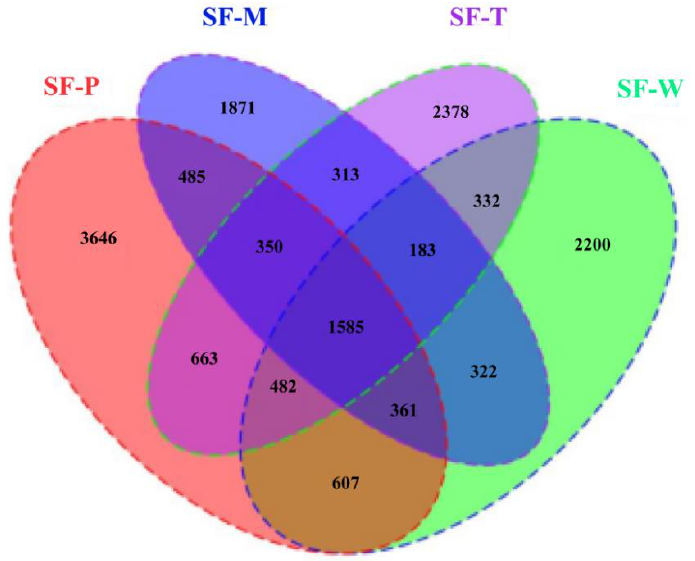
Figure 3. Venn diagram of taxonomical operational units (OTUs) of the gut bacterial of larval S. frugiperda.